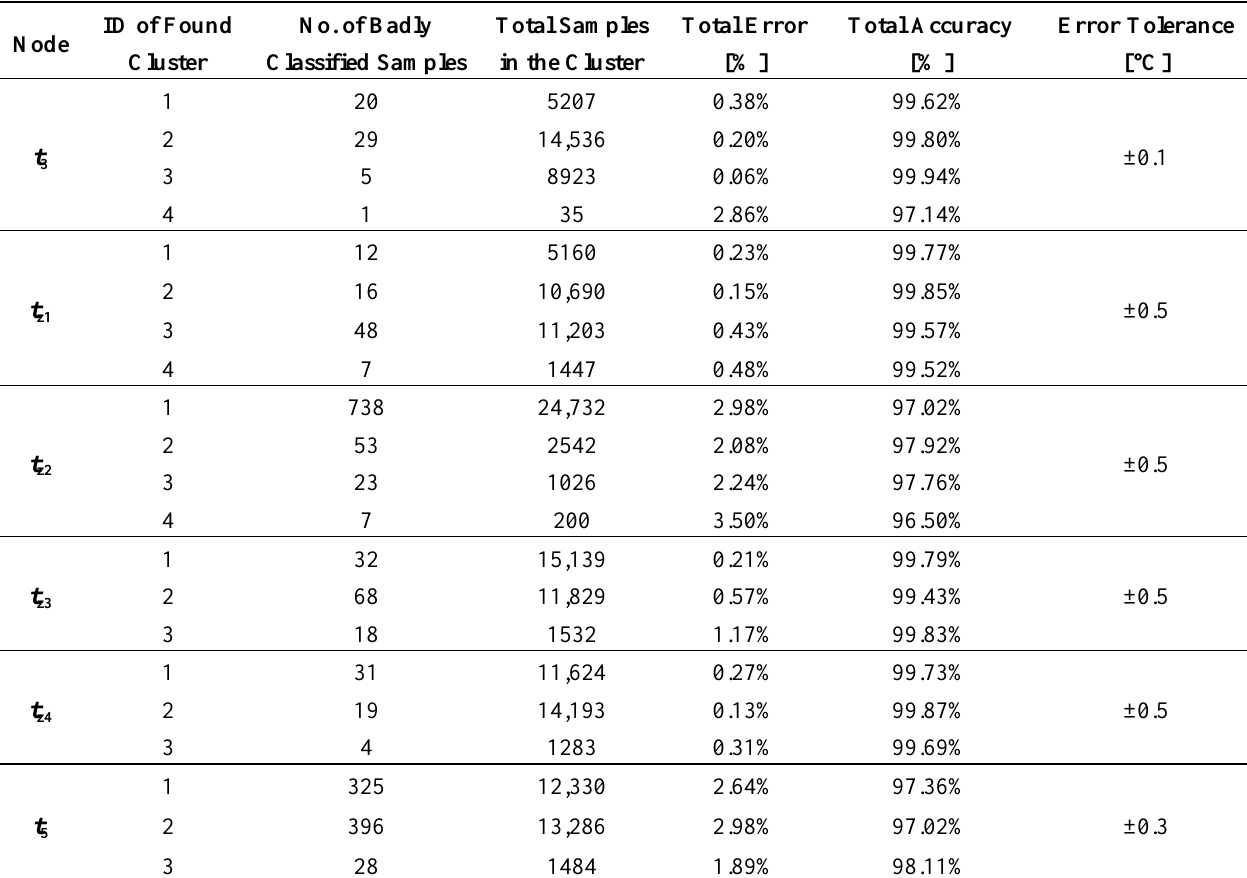
Table 1. Results of prediction using NARA neuro-fuzzy